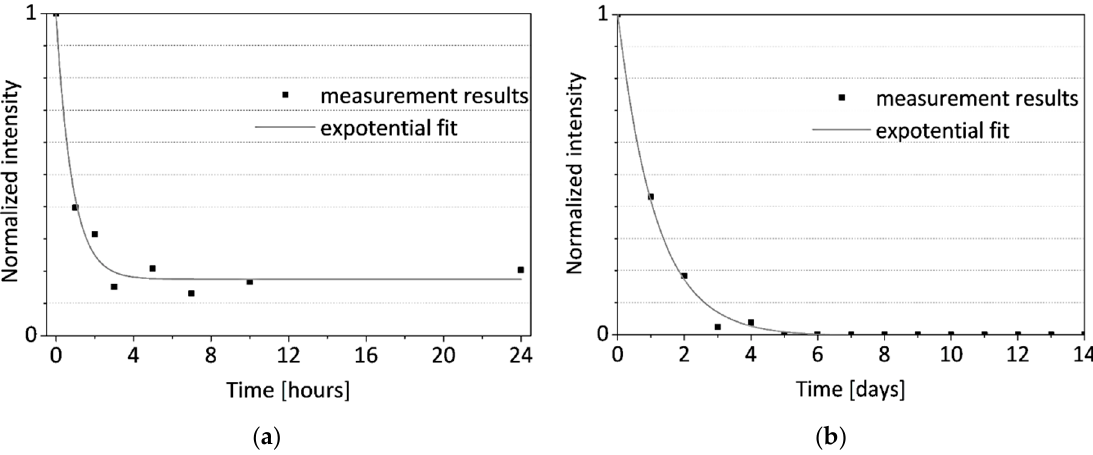
Figure 12. The time courses of normalized intensity changes of the Raman band at 967 cm –1 during ( a ) sample B24h_RS 24-h experiment and ( b ) sample B14D_RS 14-day experiment.